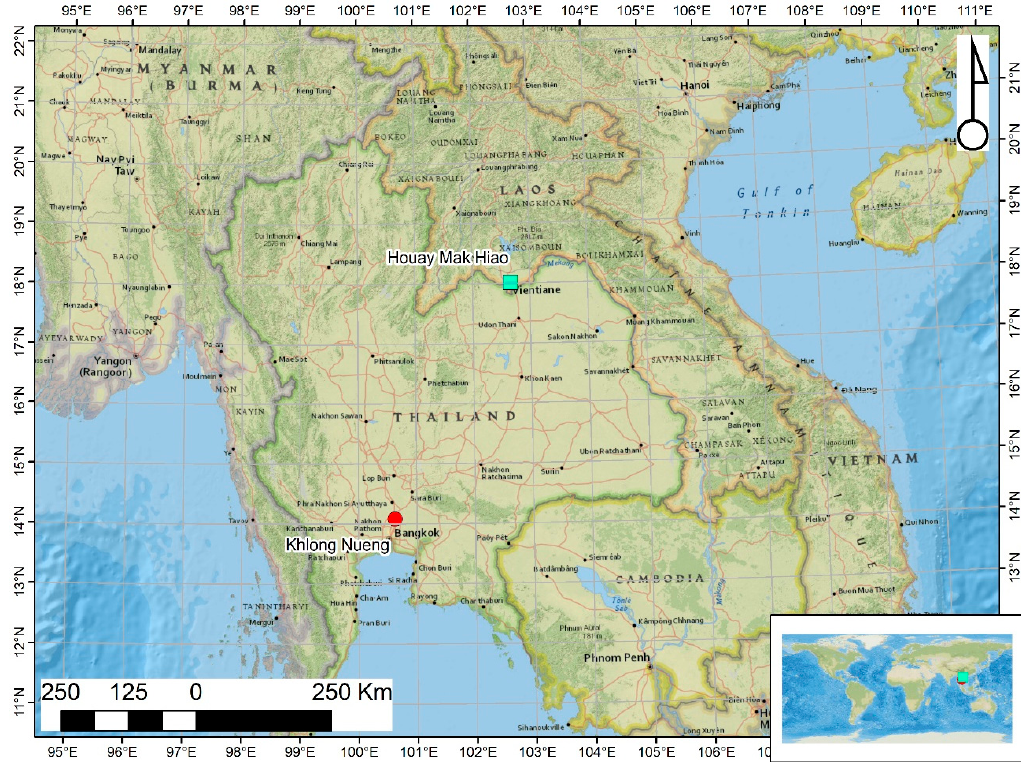
Figure 1. Location of study sites (Background map: OpenStreetMap, 2021).